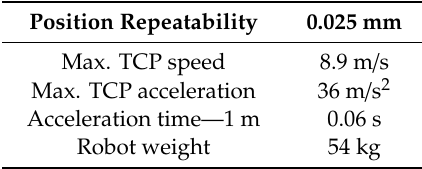
Table 1. Basic parameters of IRB1200 5 / 0.9